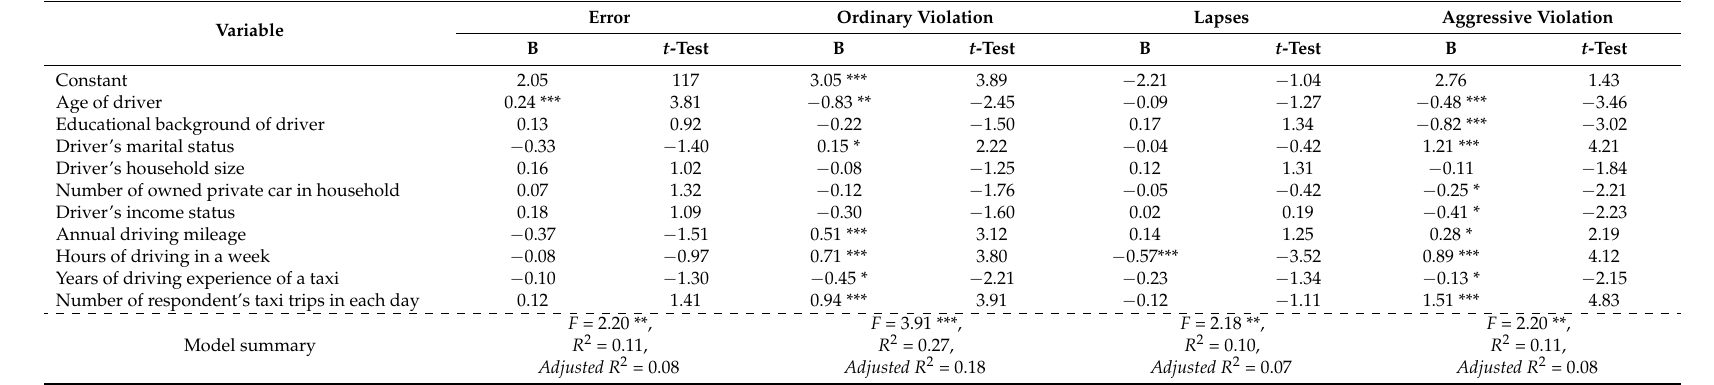
Table 4. Predictors of the four DBQ